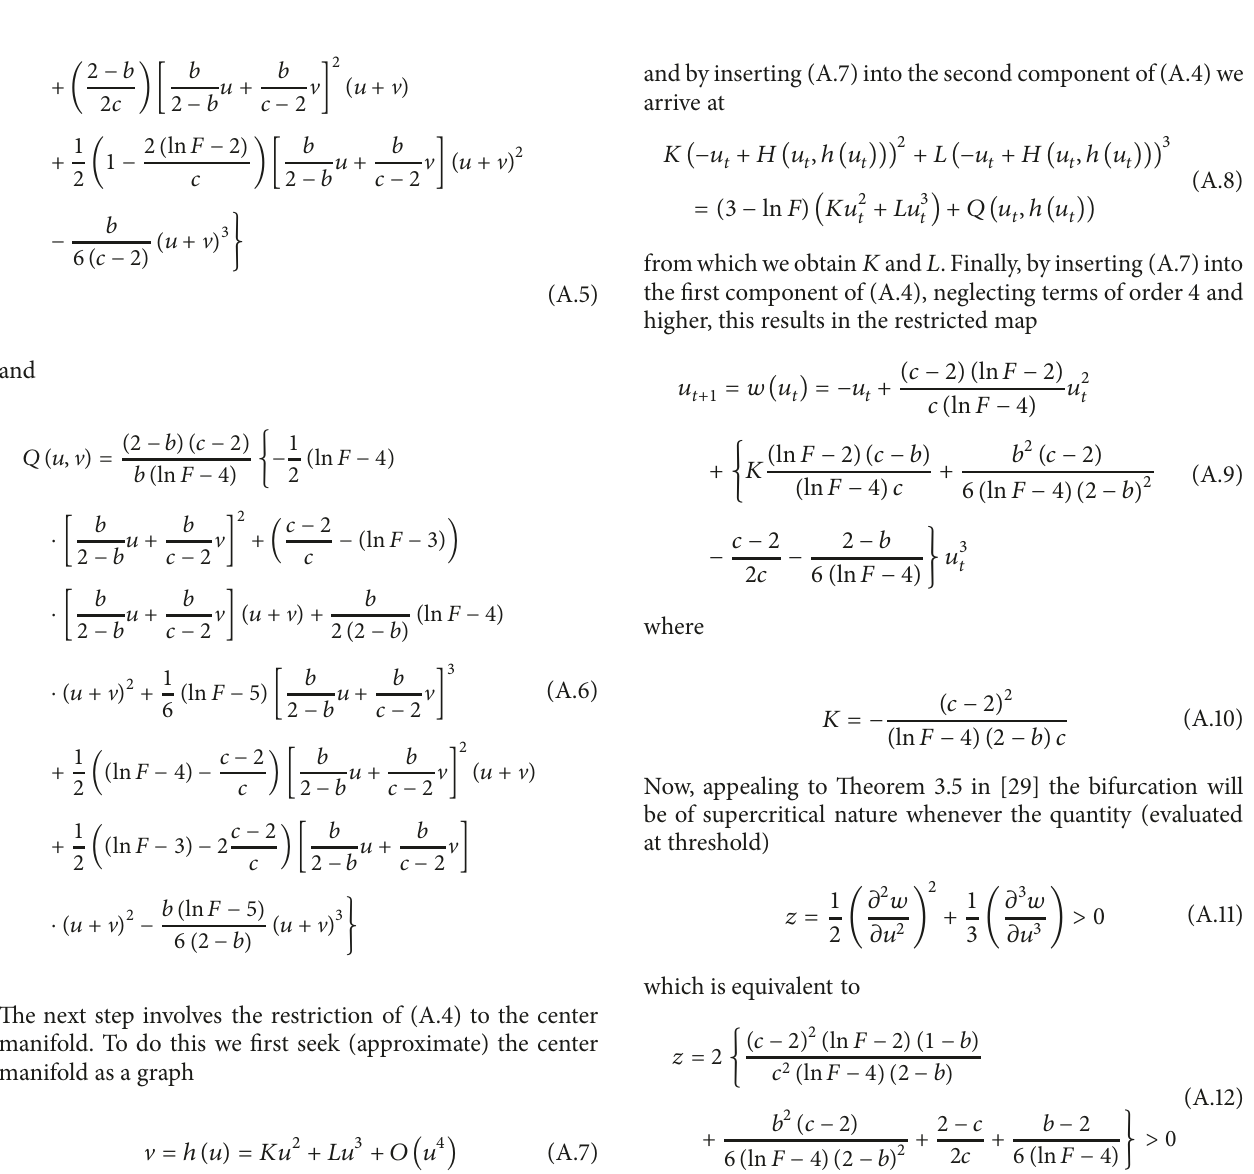
Figure 11: (a) 4 invariant curves just beyond threshold where the fourth iterate of (28) has gone through a Neimark-Sacker bifurcation. Parameter values (𝐹,𝐺, 𝐻) = (43,5,7.5) . (b) Chaotic dynamics generated by (28). Parameter values (𝐹,𝐺, 𝐻) = (43,5,8)